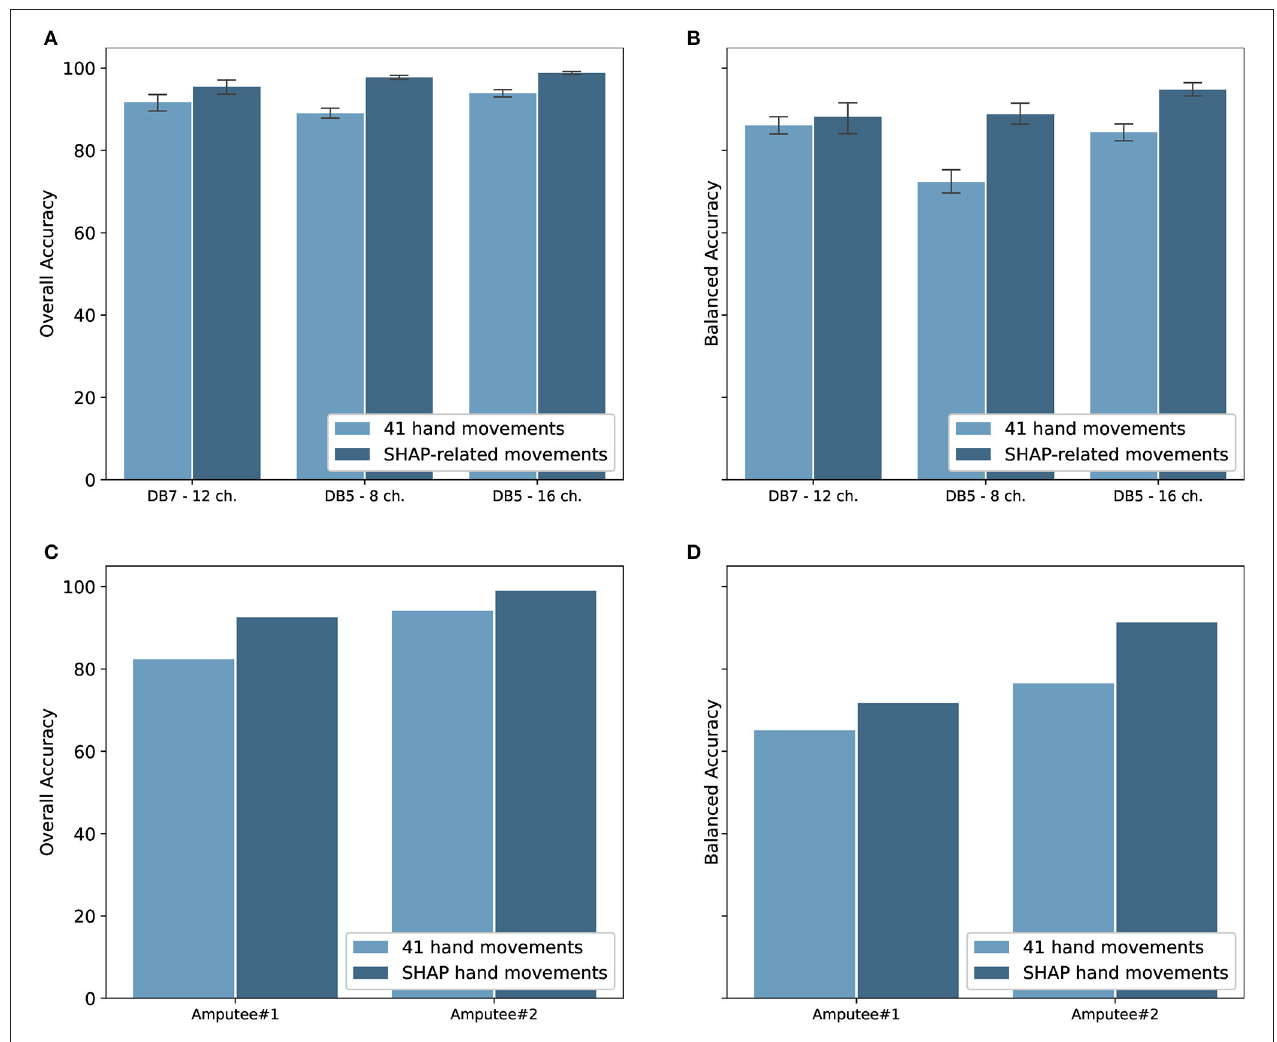
FIGURE 6 | (A) Overall accuracy and (B) balanced accuracy of the proposed deep neural network classifiers for intact participants; (C) overall accuracy and (D) balanced accuracy of the classifiers for amputee participants. Note that (C,D) do not show standard deviation as there is only one subject shown in each graph.